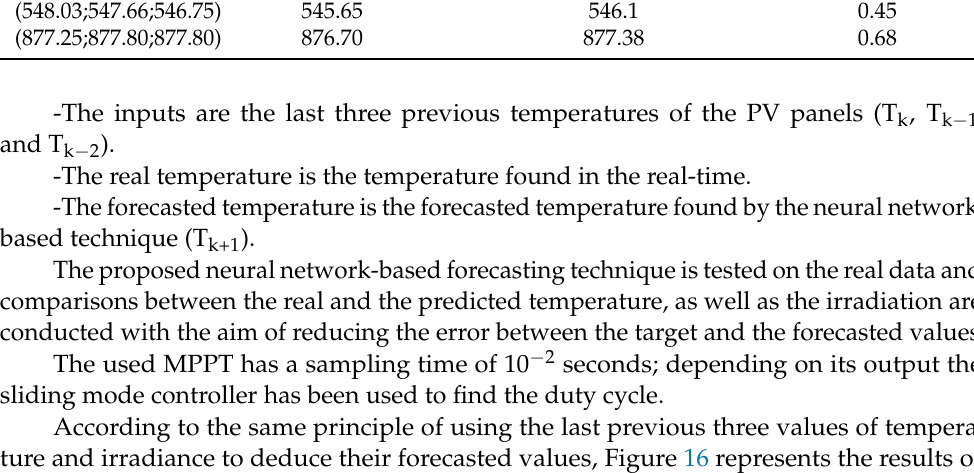
Table 2. Irradiation forecast testing.